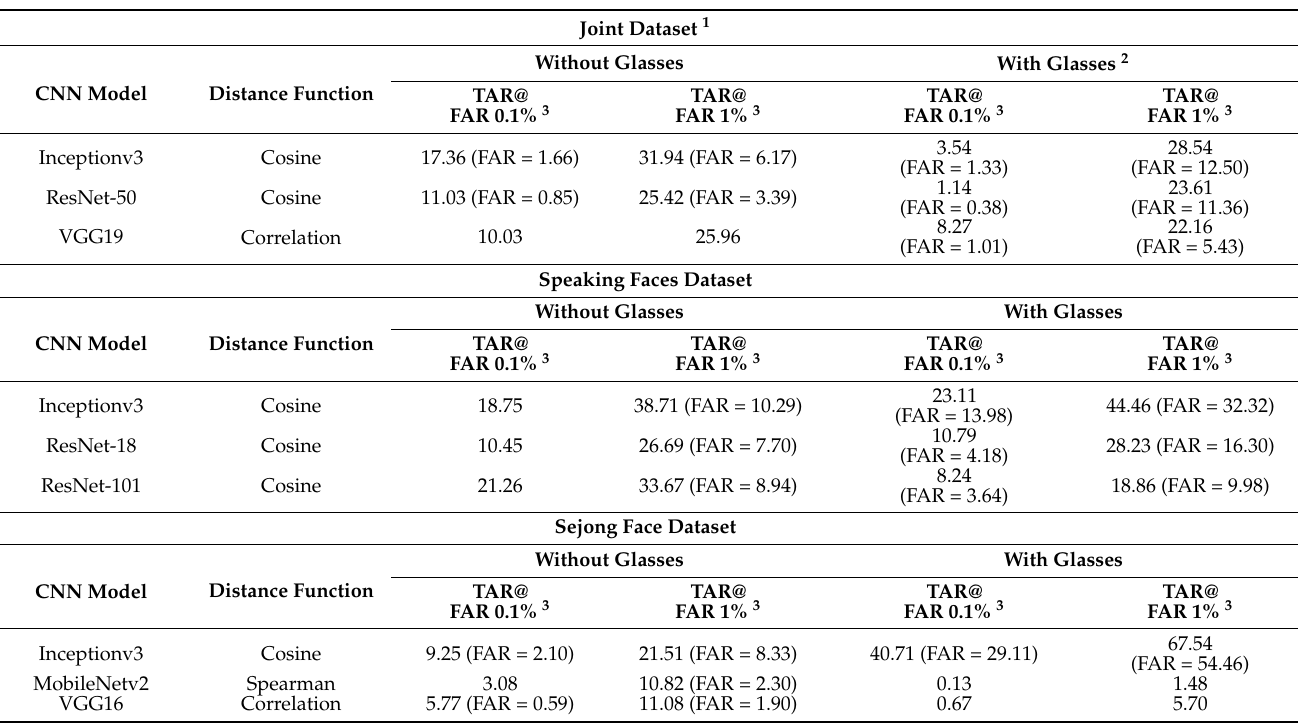
Table 5. Performance of Triplet algorithms for the joint 1 , Speaking Faces, and Sejong Face datasets for a thermal anchor